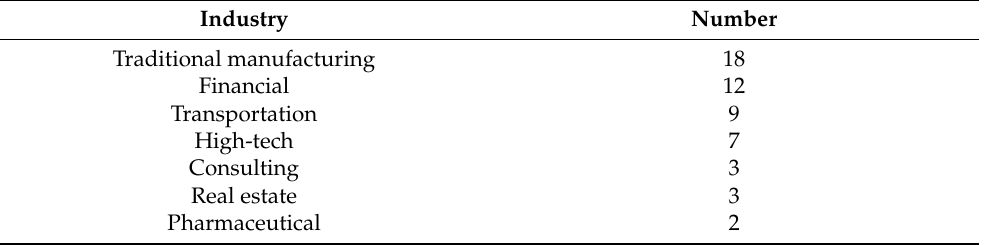
Table 1. Sample industry type statistics.